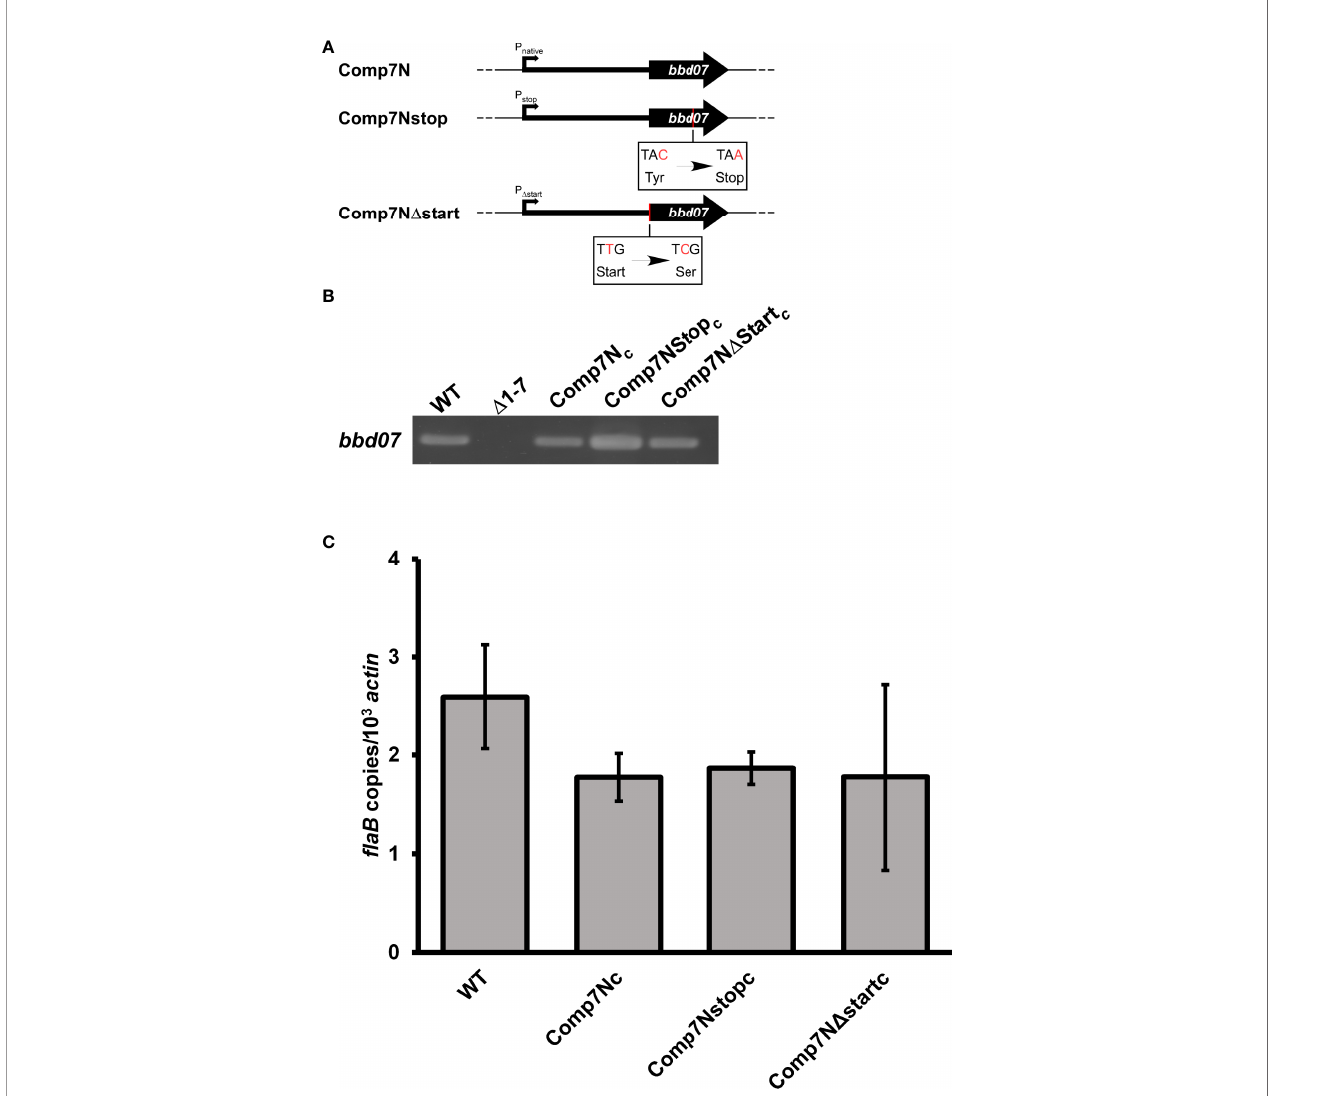
FIGURE 1 | Neither introduction of a stop codon nor disruption of potential start codon abrogates the function of the bbd07 -encoded gene product. (A) Diagrams indicating where mutations were made with respect to the discontinued bbd07 ORF annotation (thick black arrow, 117 bp). Thick black line upstream of arrow represents 200 bp of upstream sequence included in the constructs. Mutated base pairs are indicated with red text. (B) PCR veri fi cations of successful complementation using P1050/P1051. (C) Mice were inoculated subcutaneously with indicated strains at a dose of 5x10 3 total spirochetes. qPCR analysis was used to assess bacterial burden in heart tissues harvested from mice 28 days post-inoculation. Reactions were performed in duplex with probes/primers for fl aB (P199, P200, P201) and mouse actin (P202, P203, P1086). Data bars indicate the average number of fl aB copies per 10 3 actin copies in heart tissues from 5 mice. Students t-test was performed to assess signi fi cance of differences in heart tissue colonization between each recombinant strain and wild type ( P < 0.05). No signi fi cant differences were observed. Error bars indicate SEM for each group (n =